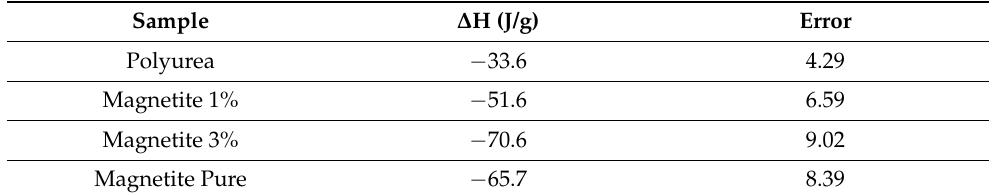
Figure 7. Thermogravimetric curves (TGA) of the pure magnetite, the neat polymer, and the compos- ites with 1 and 3% of magnetite nanoparticles. Table 2. Enthalpy change calculated by integrating the peak area due to interactions between the polymer and magnetic